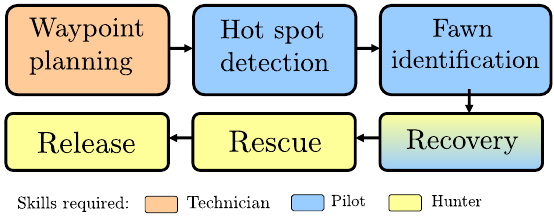
Figure 6: Workflow of the fawn rescueing process